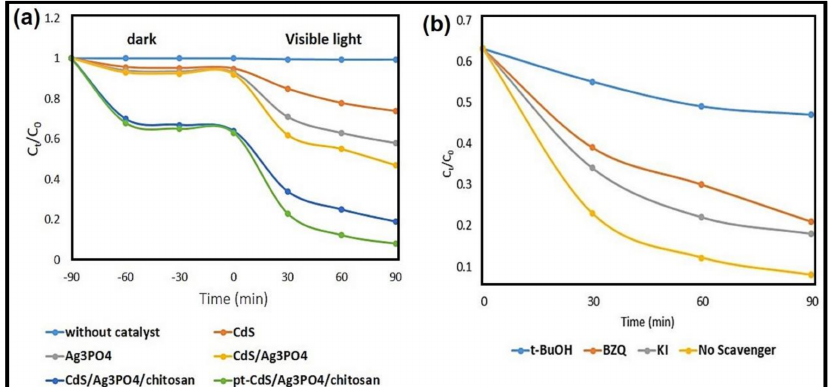
Figure 7. ( a ) The degradation e ffi ciency for methylene blue (MB) (10 − 5 mol / L) removal in the process of prepared samples under visible light irradiation. ( b ) E ff ect of various scavengers on the degradation of MB by Pt-Ag 3 PO 4 / CdS /